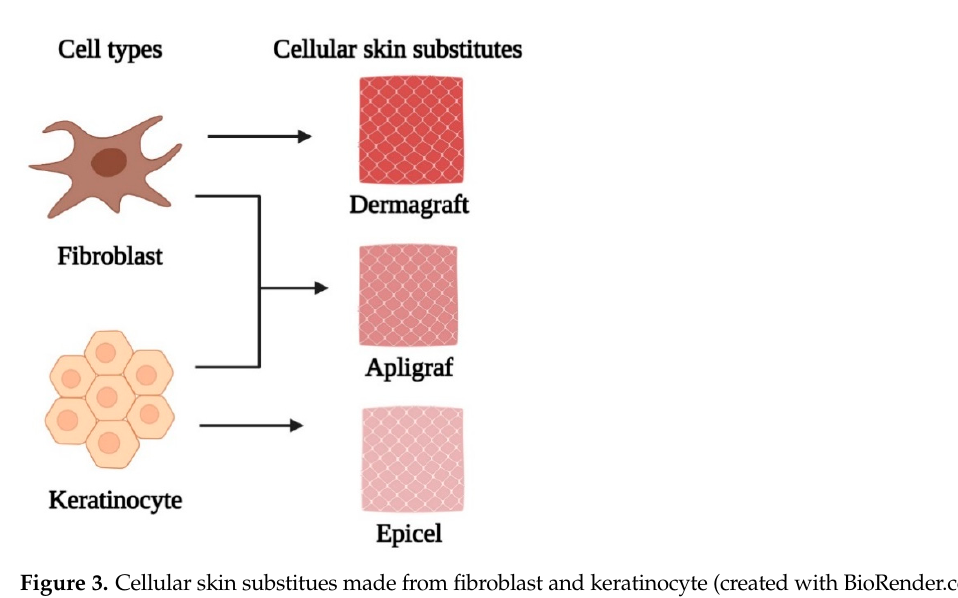
Figure 3. Cellular skin substitues made from fibroblast and keratinocyte (created with BioRen ‐